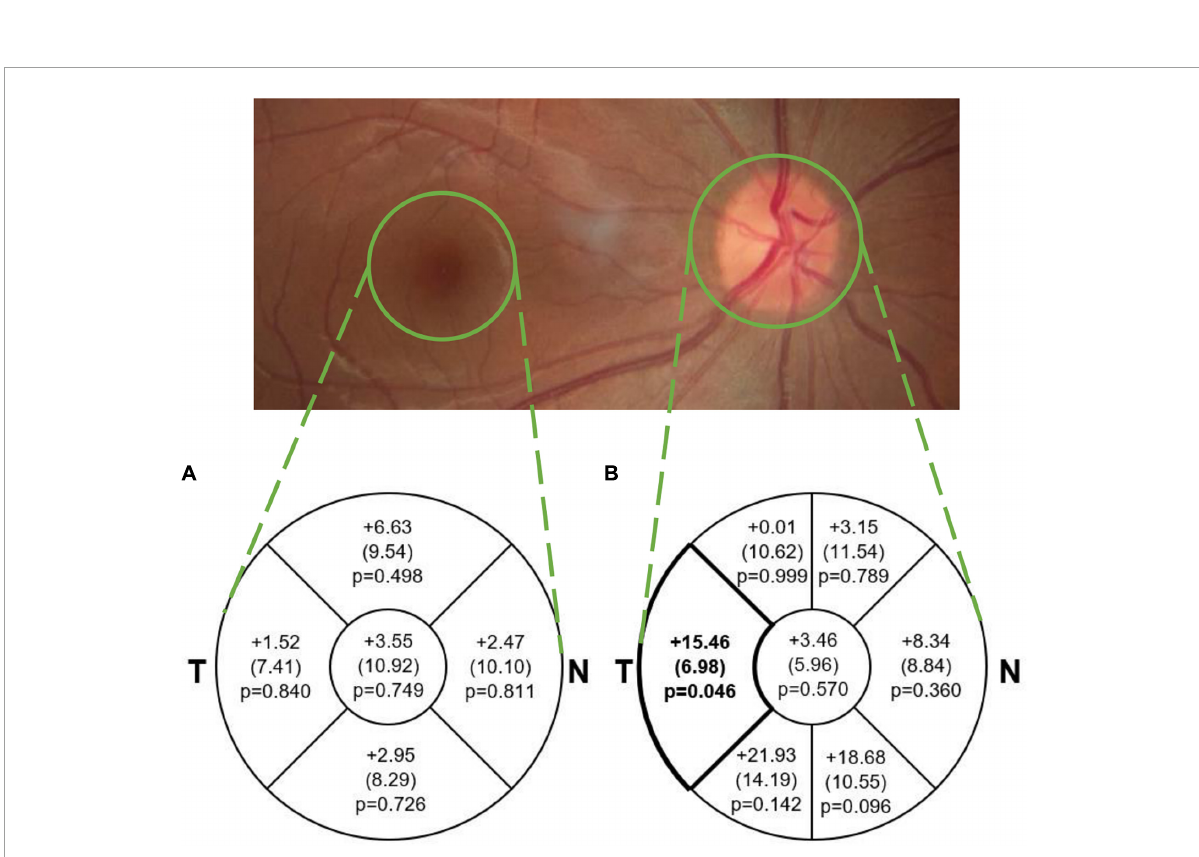
FIGURE2 Mean (SE) difference (tauopathy – TDP43, µ m) in average (A) macular sectoral thickness and (B) pRNFL sectoral and global thickness. The difference in pRNFL thickness between groups in the temporal sector ( p < 0.05; medium effect size of 0.61) is illustrated in bold. This difference was not significant after adjusting for multiple comparisons. Note that average thickness in the macular scan is within the area of each sector and represents total retinal thickness, while in the pRNFL scan it is along the circular line of each sector and represents RNFL thickness only. T, Temporal; N,